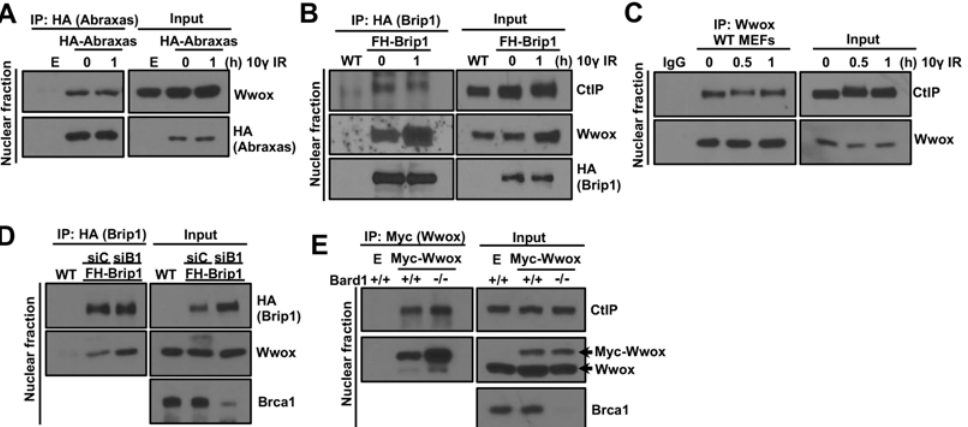
Figure 2. Wwox interaction with Abraxas, Brip1, and CtIP is independent of its binding to Brca1. ( A ) Murine Abraxas of the A complex binds to Wwox. HA-Abraxas plasmids were transfected into wild type (WT) MEFs and pulled down with HA-magnetic beads. Empty vector ( E ) transfected WT cells were used for negative control; ( B ) Murine Brip1 of the B complex binds to Wwox, as shown by its co ‐ IP of Wwox and CtIP protein. IP was performed in MEFs expressing Flag ‐ HA tagged wild type Brip1 protein (FH ‐ Brip1). Brip1 protein was pulled down with HA beads and immunoblotted with CtIP and Wwox antisera. WT MEFs that do not express FH-Brip1 were used for negative control for HA pull-down; ( C ) Wwox interacts with CtIP in WT MEFs; ( D ) Wwox-Brip1 interaction is Brca1-independent. Wwox-Brip1 interaction occurred in both siControl (siC) and siBrca1 (siB1) transfected FH ‐ Brip1 MEFs. Wild type MEFs (WT) that do not express FH ‐ Brip1 served as negative control for HA pull ‐ down; ( E ) Wwox ‐ CtIP interaction is Brca1 ‐ independent. IP was performed in Bard1 +/+ ; 53BP1 − / − (labeled Bard1 +/+) and Bard1 − / − ; 53BP1 − / − (labeled Bard1 − / − ) MEFs. Wwox ‐ CtIP binding occurred in the Bard1 − / − ; 53BP1 − / − cells where Brca1 protein is unstable (E: empty vector transfection).